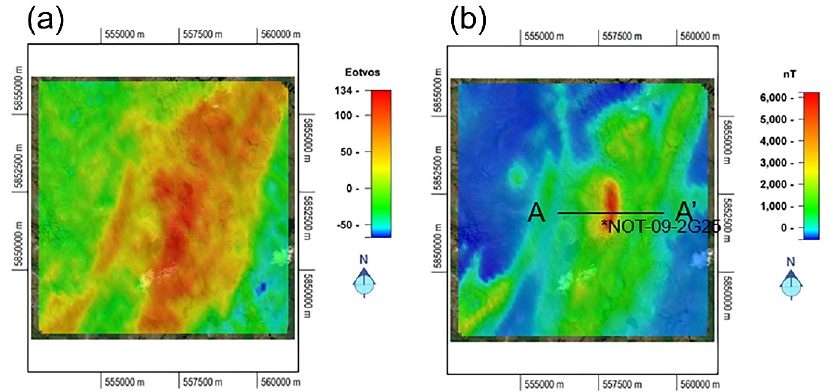
Figure 6. Panel ( a ) shows the Gzz component of the observed AGG data in UTM (16N) coordinates in panel ( a ). Panel ( b ) presents the filtered TMI data map with the removed regional trend. Profile AA’ is shown by the black line. The location of drill hole NOT-09-2G25 is shown by the black asterisk. A comparison of vertical sections of the 3D models obtained from the various in- version methodologies is shown in Figure 7. It is clear that the models obtained from a joint inversion with either Gramian or joint focusing constraints have sharper geospatial boundaries and a higher degree of structural correlation, when compared to the models obtained from standalone inversions. It is important to note that all inverted 3D models share the same level of data misfit.